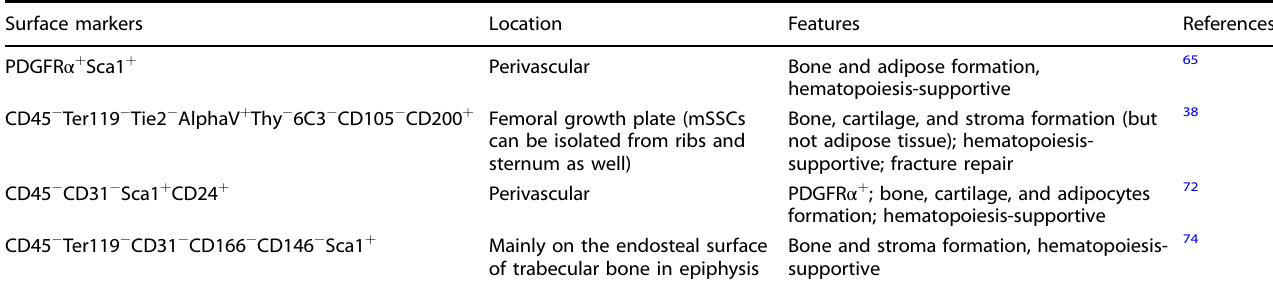
Table 3. Mouse skeletal stem cells labeled by immunophenotypic markers Surface